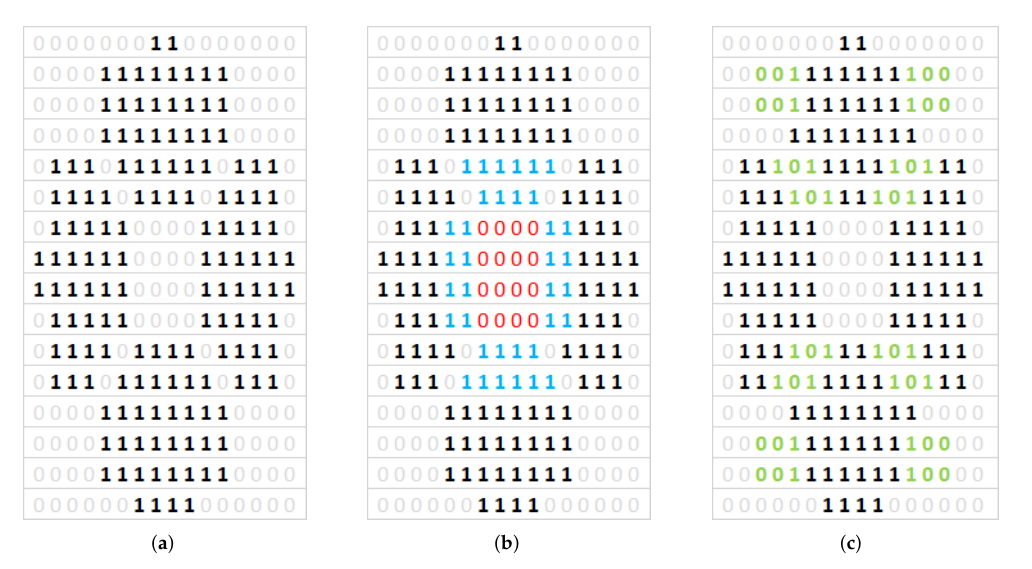
Figure 18. Calculated binary patterns (256 regions) for presented models (Figure 16a) with use of proposed method. ( a ) generated binary pattern, ( b ) marked first cascade elements, ( c ) marked second cascade